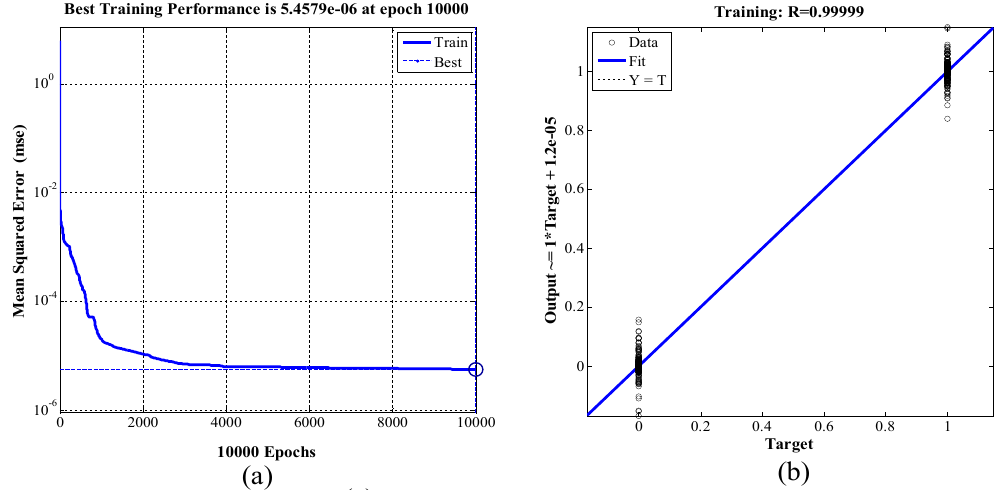
Electronics 2021 , 10 , x FOR PEER REVIEW Figure 12. ( a ) performance and ( b ) regression of ANN training after applying optimal parameters of ANN-GA.